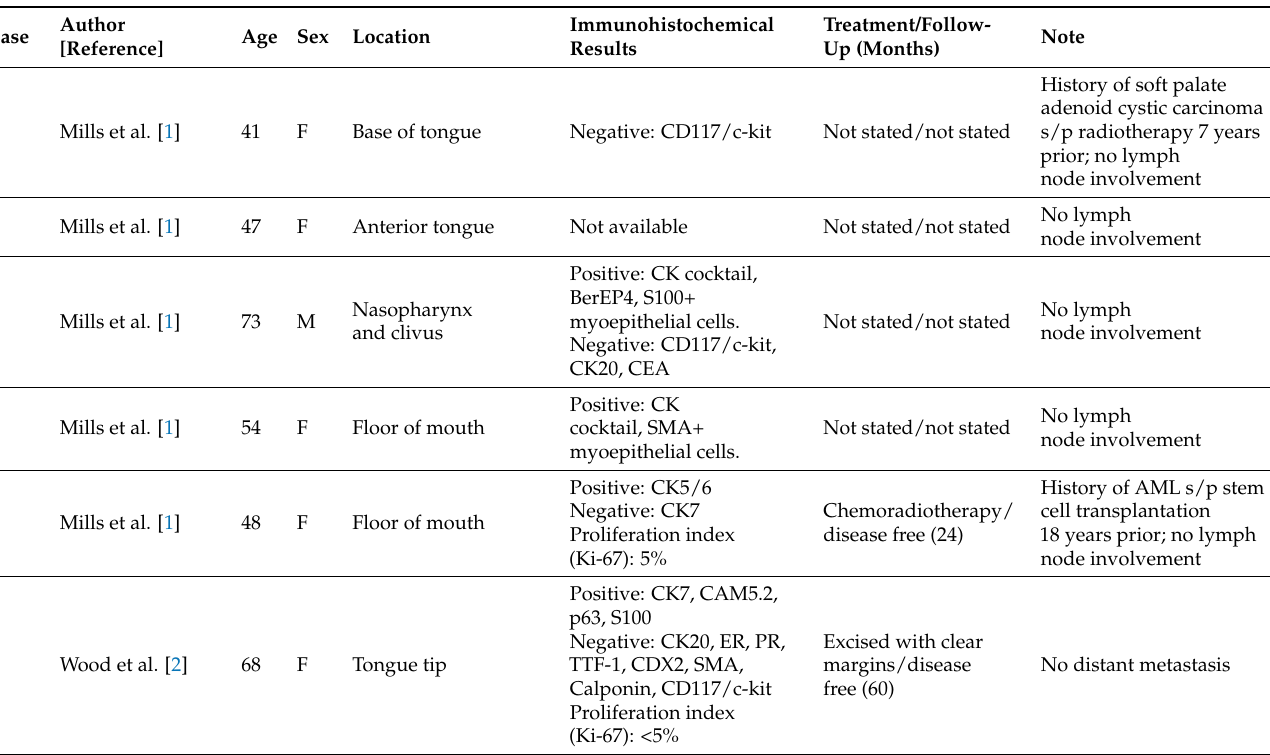
A summary of case reports of sclerosing microcystic adenocarcinoma with clinicopathologic